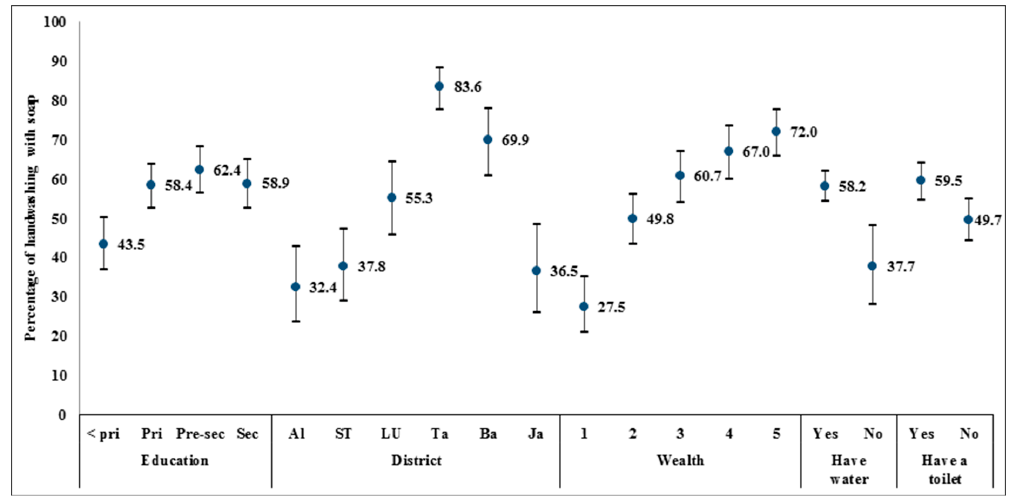
Figure 1. Percentage of respondents who washed hands with soap by education, district, wealth, and access to water and sanitation. Notes: <pri = Less than primary education, Pri = Primary education completed, Pre-sec = Pre-secondary education, Sec = Secondary education or higher. Al = Alor, ST = Sumba Timur, LU = Luwu Utara, Ta = Takalar, Ba = Barru, Ja = Jayapura. Wealth 1 = Poorest, 2 = Poorer, 3 = Middle, 4 = Richer, 5 = Richest.